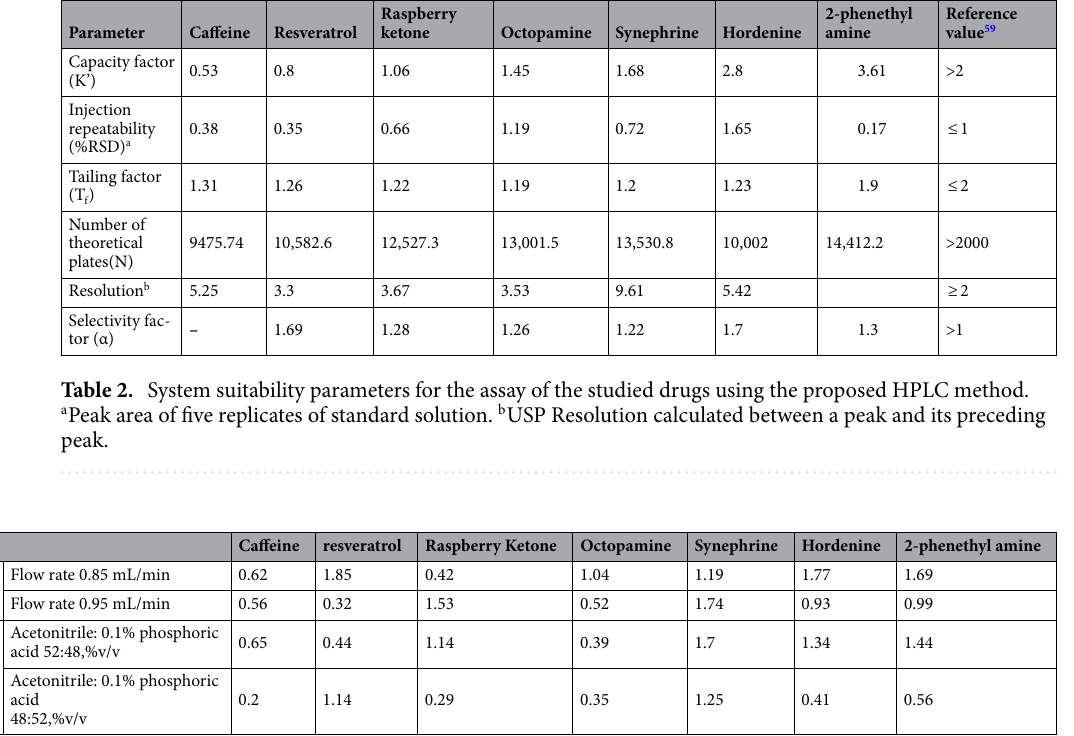
Table 3. Robustness results of the proposed HPLC method expressed as %RSD of the drug assay.